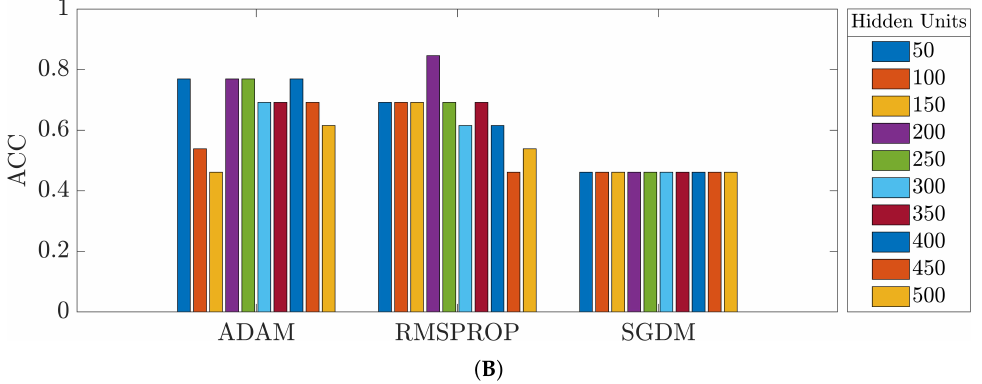
Figure 12. Accuracy of the control data from the networks trained with the 35-mer adenosine dataset with 100 augmented and original data points per class: ( A ) ULSTM network; ( B ) BLSTM